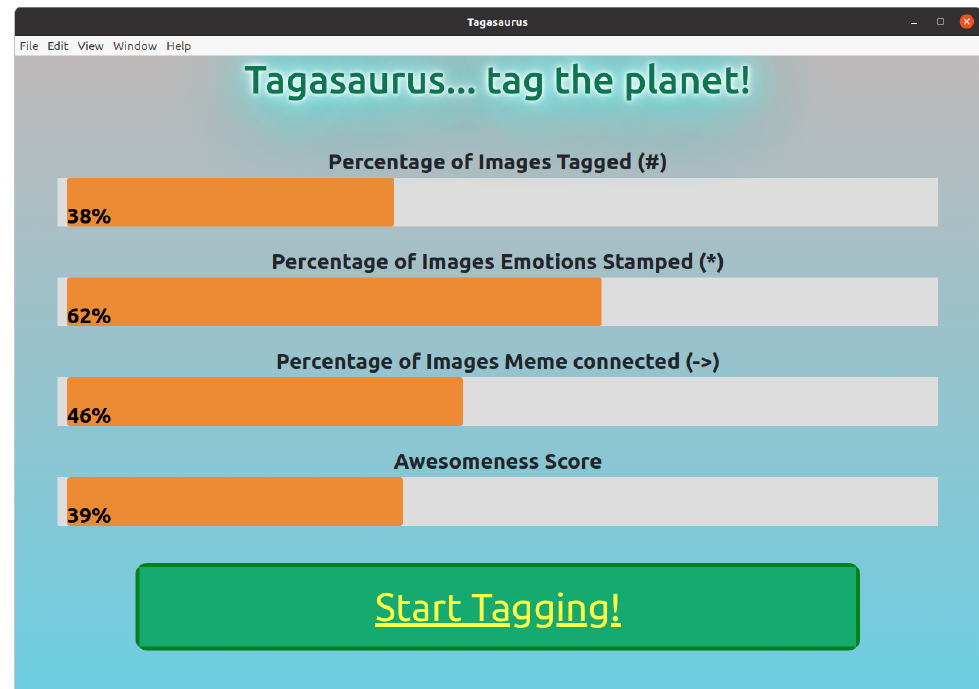
Figure 2. A screenshot of what a user can see when starting Tagasaurus after having previously used the program to save image annotations. Four skill bars are shown providing feedback to the user for where they have provided more or less information for their photo